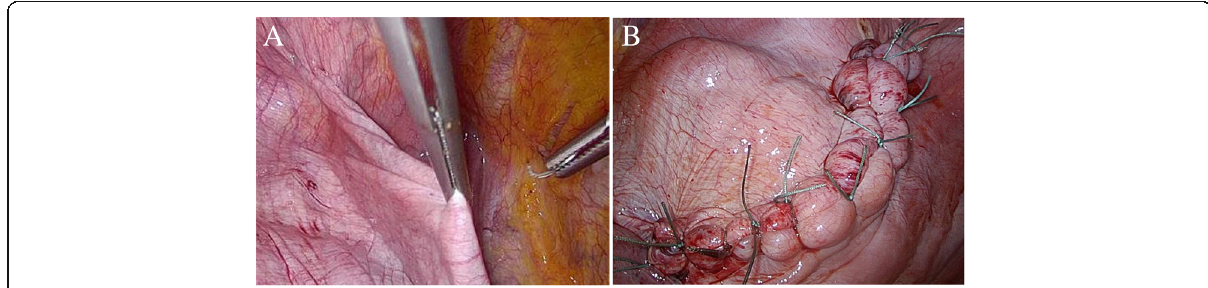
Fig. 3 Intraoperative photographs. a T he diaphragm was nearly flat using CO 2 insufflation. b After completion of diaphragmatic